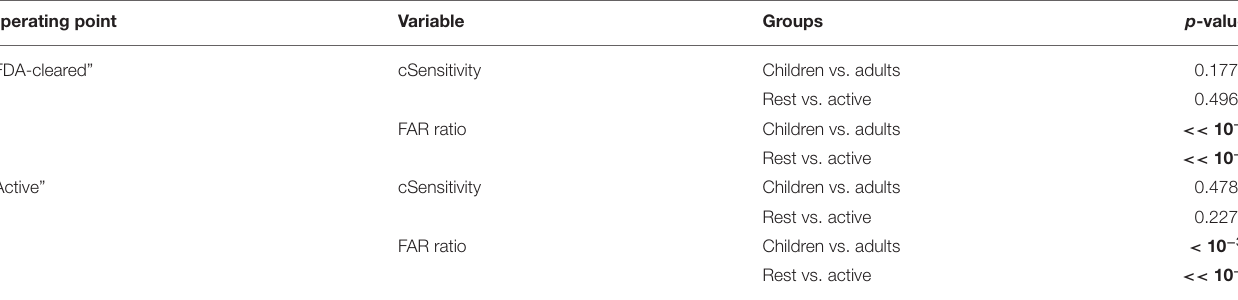
TABLE 4 | Statistical comparison of “cSensitivity” and FAR between pediatric and adult patients, and between Rest and Active periods, for the two operating points. Operating